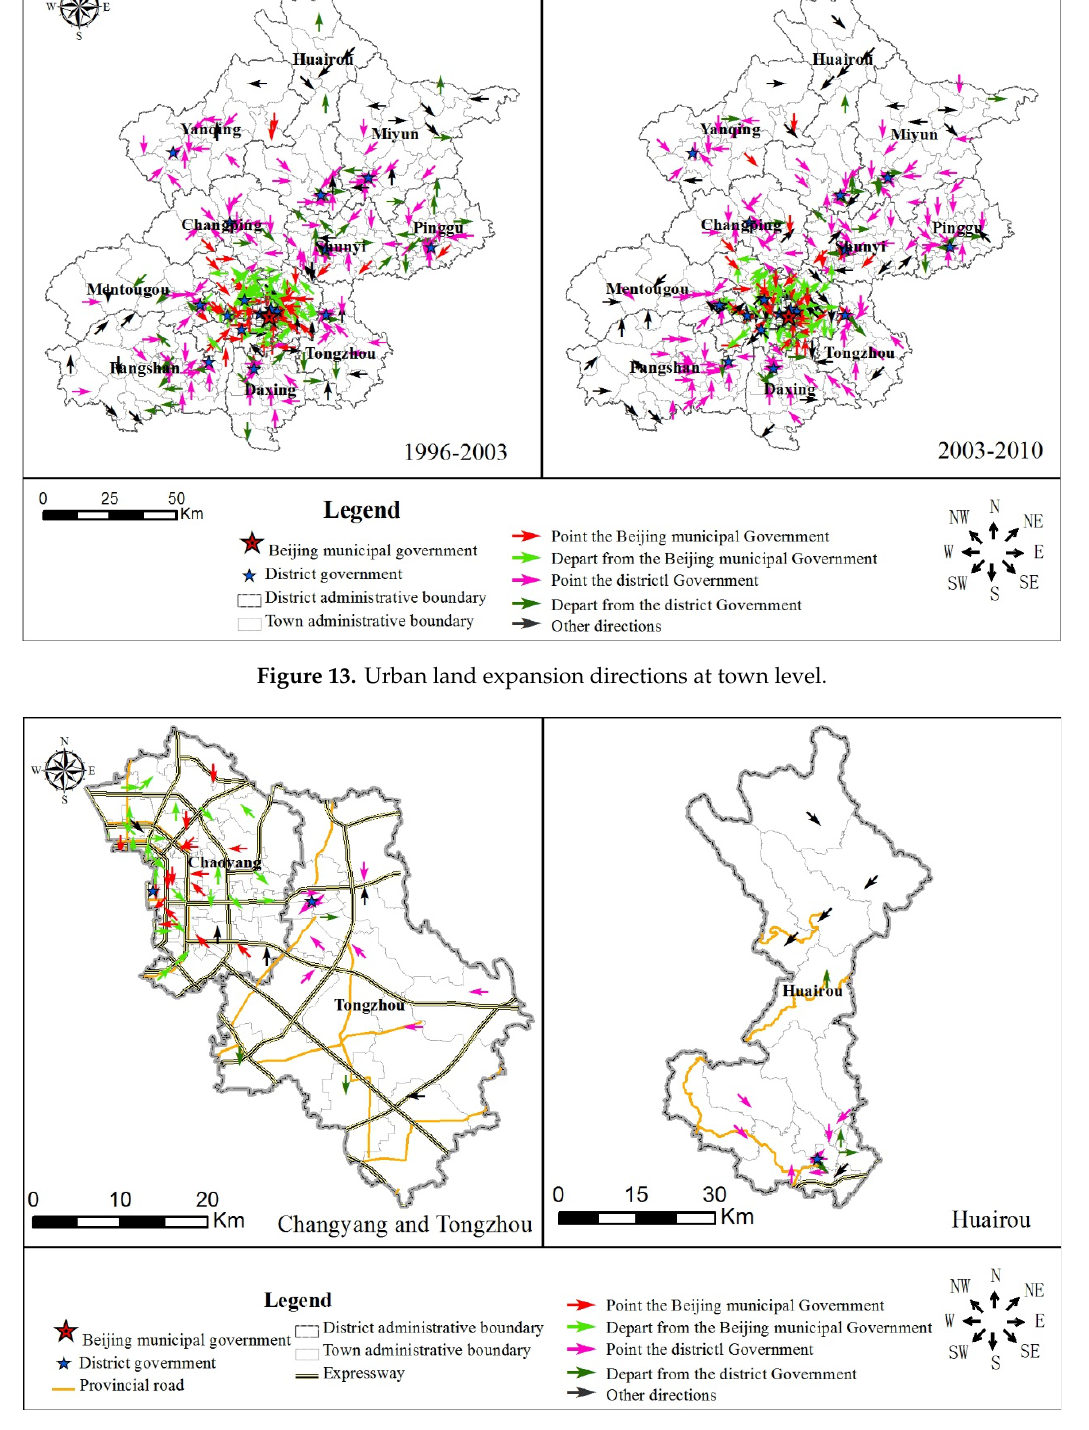
Figure 14. Urban land expansion directions in Changyang, Tongzhou, and Huairou.